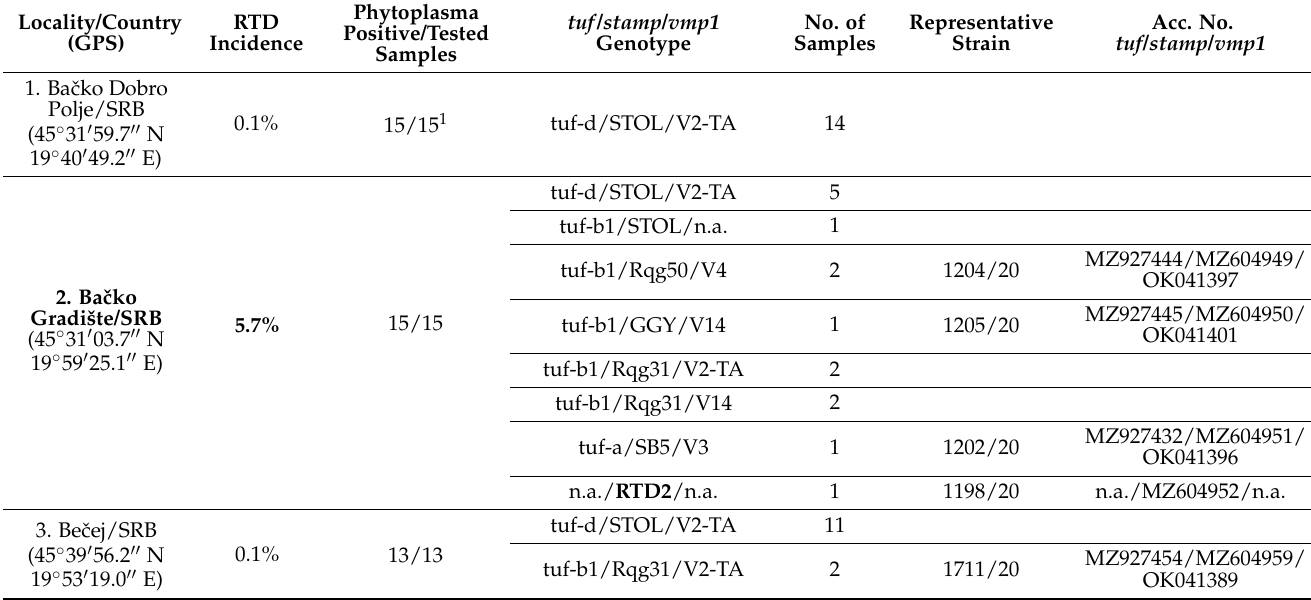
Table 1. RTD-symptomatic sugar beet and red beet samples analysed in this work, as well as obtained ‘ Ca . P. solani’ multilocus